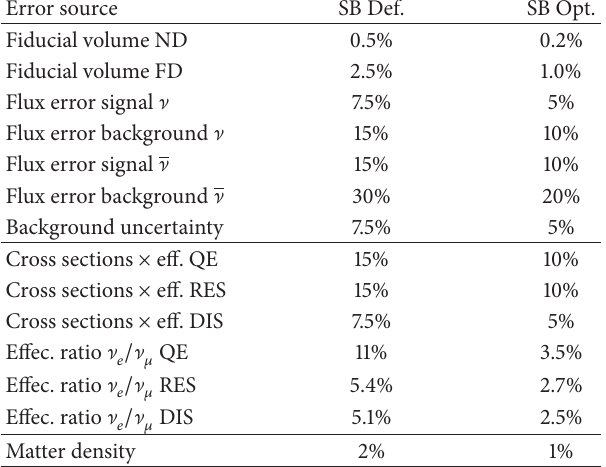
Table 3: The different sources of uncertainty that contribute to the total systematic uncertainty in the determination of the CP violating angle 𝛿 CP .Thistableisanextractionofinformationfromatableused in [18]. Here, only the uncertainties for the Super Beam cases “SB Def.” (for default) are used to obtain the results shown in Figures 8 and 10 and “SB Opt.” (for optimistic) to obtain the results shown in Figure